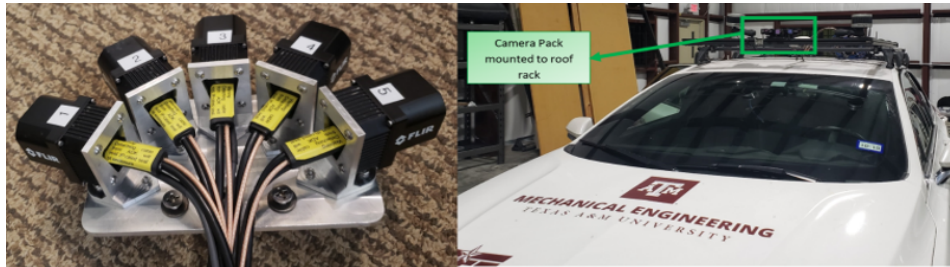
Figure 4. Thermal camera assembly. Each of the five thermal cameras used for the image stitching are shown with the numbers 1–5.